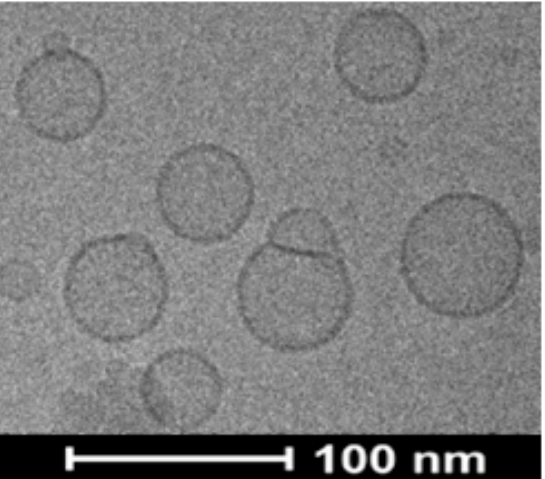
Figure 2. A representative cryo-TEM image depicting the structure of Lip DOPE -siHSV (N:P ratio 5:1) (scale bar = 100 nm). Table 1. The physicochemical properties of Lip DOPE -siHSV .